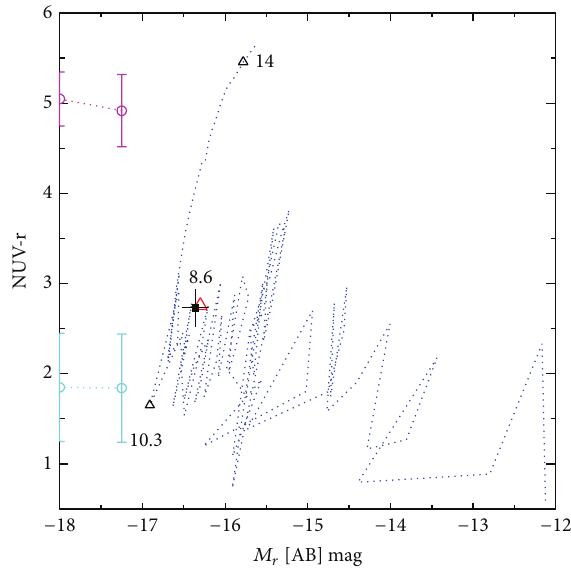
Figure 7: The rest-frame evolution of (NUV-r) versus 𝑀 𝑟 color- magnitude diagram from our simulation of UGC 7639. Dotted line shows its evolutionary path; open symbols mark some meaningful evolutionary times in Gyr (see text); (red) triangle shows its current position. The observed position is given by the filled square, accounting for the same distance modulus as in Figure 4, and the corresponding 1 𝜎 uncertainty. The red (magenta) and the blue (cyan) sequences are also plotted following the same prescriptions as in Figure